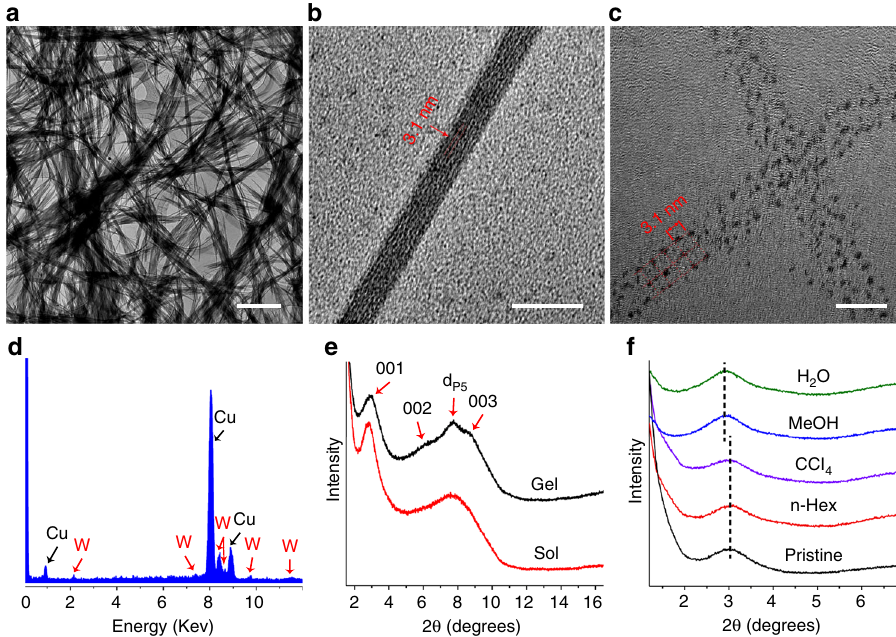
Fig. 3 Co-assembly and supramolecular framework structure of (TBP) 4 SiW@BCB in gel. a – c TEM images of gel assemblies at different ampli fi cation scales. d Energy dispersive X-ray spectrum (EDX) focusing on the gel assembly. e Powder X-ray diffractions of sol and gel. f Powder X-ray diffractions of xerogel powder after treating with different solvents. Scale bars, 2 μ m ( a ), 100 nm ( b ), 10 nm ( c ). Source data are provided as a Source Data fi